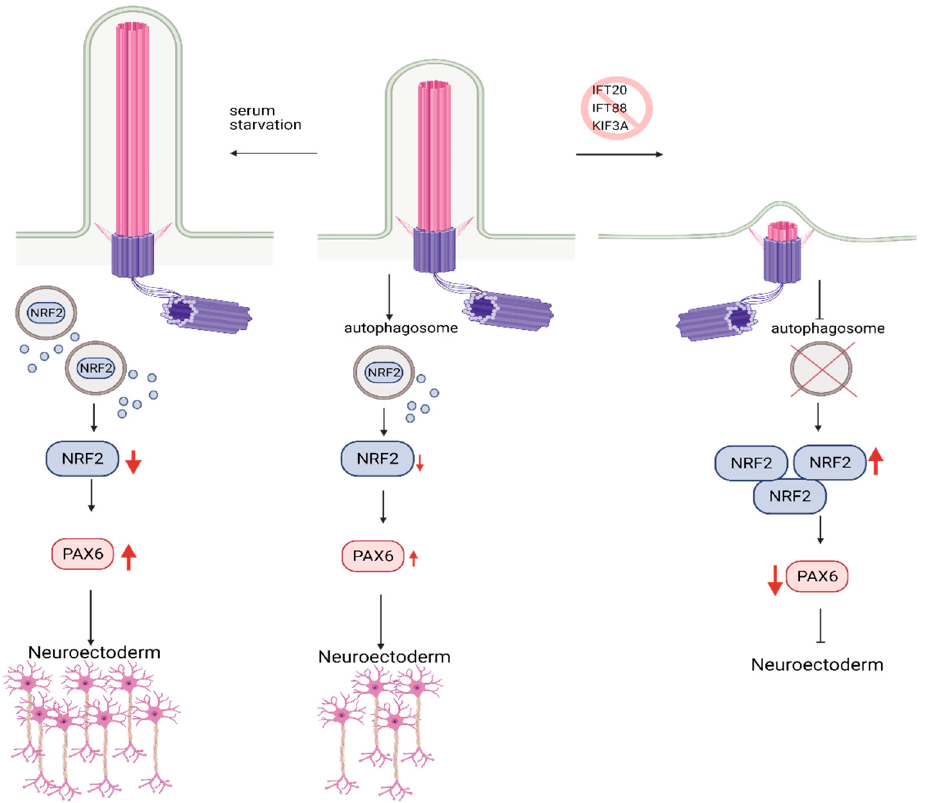
Figure 5. Role of Autophagy and primary cilia in embryonic stem cell lineage specification. Primary cilium promotes autophagosome formation in hESCs, keeping embryonic development in check via the controlled degradation of Nrf2. Inhibition of primary cilia formation results in increased levels of Nrf2 due to constrained autophagosome formation. Increased levels of Nrf2 reduce the expression of PAX6, neuroectoderm fate-determinant transcription factor, which in turn results in inhibition of hESC’s commitment to neuroectoderm lineage. Conversely, activation of primary cilia via serum starvation causes higher levels of PAX6 expression and promotes commitment to neuroectoderm lineage. Created with BioRender.com.